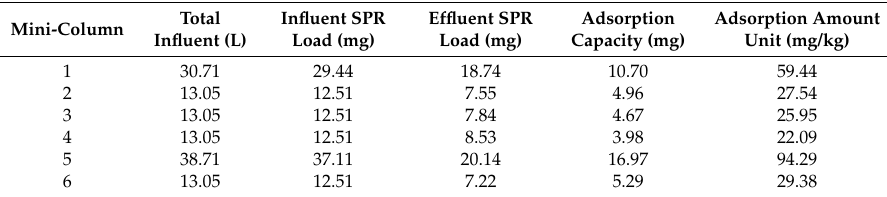
Table 7. Saturation point and accumulation of SRP.